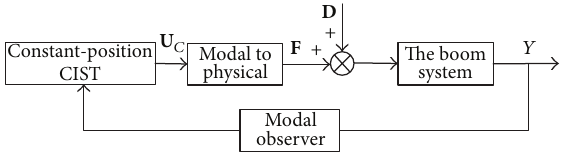
Figure 6: Block diagram of vibration control.